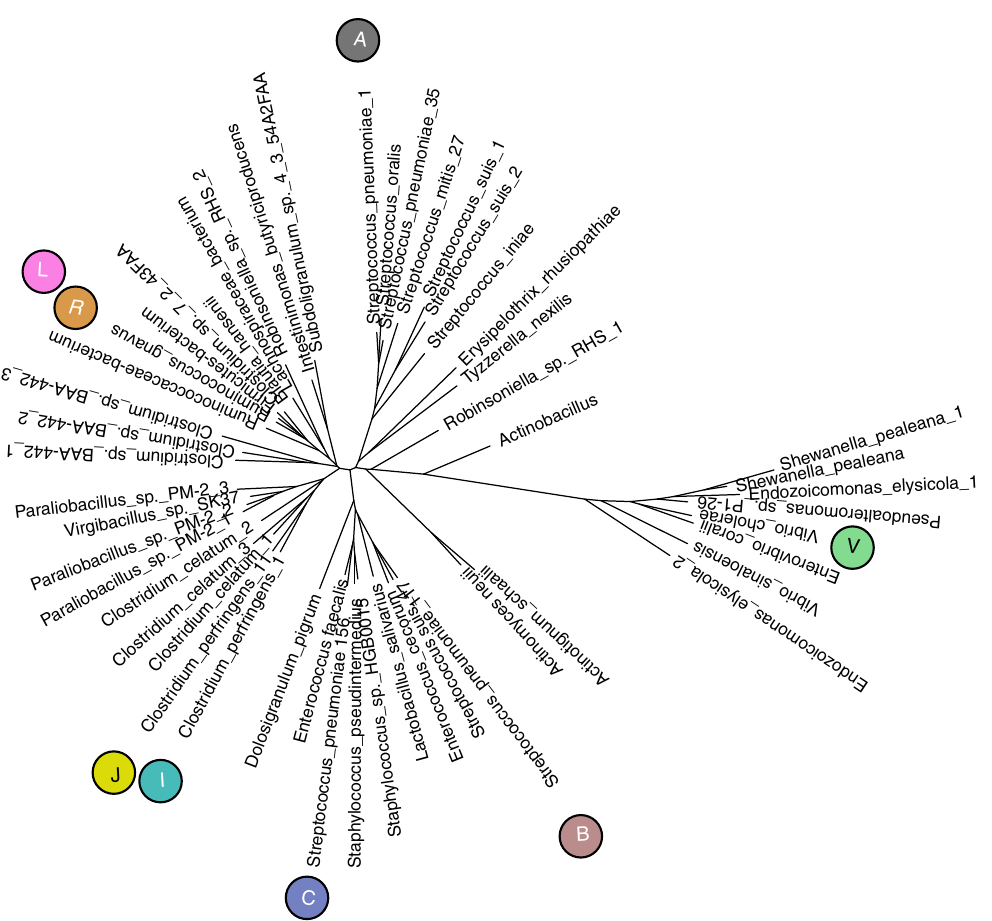
Fig. 3 Distance-based tree of canonical and Vibrio- type CBM40 sequences. Tree of 51 non-redundant sequences (80% identity level) calculated by neighbour-joining using evolutionary distances estimated by applying the PMB model of amino acid changes, including all sites and using a uniform rate of evolution. The representative sequences corresponding most closely (at least 97% identical) to the 7 bacterial structure-determined sequences are shown with symbols, coloured in accordance with Supplementary Fig. 1: “ A ” , Sp CBM40_NanA; “ B ” , Sp CBM40_NanB; “ C ” , Sp CBM40_NanC; “ I ” , Cp CBM40_NanI; “ J ” , Cp CBM40_NanJ; “ R ” , Rg CBM40; “ V ” , Vc CBM40_NanH. Additionally, “ L ” denotes Md CBM40_NanL closest to the bacterial sequence of highest identity (70% identical to Rg CBM40) as only bacterial sequences were